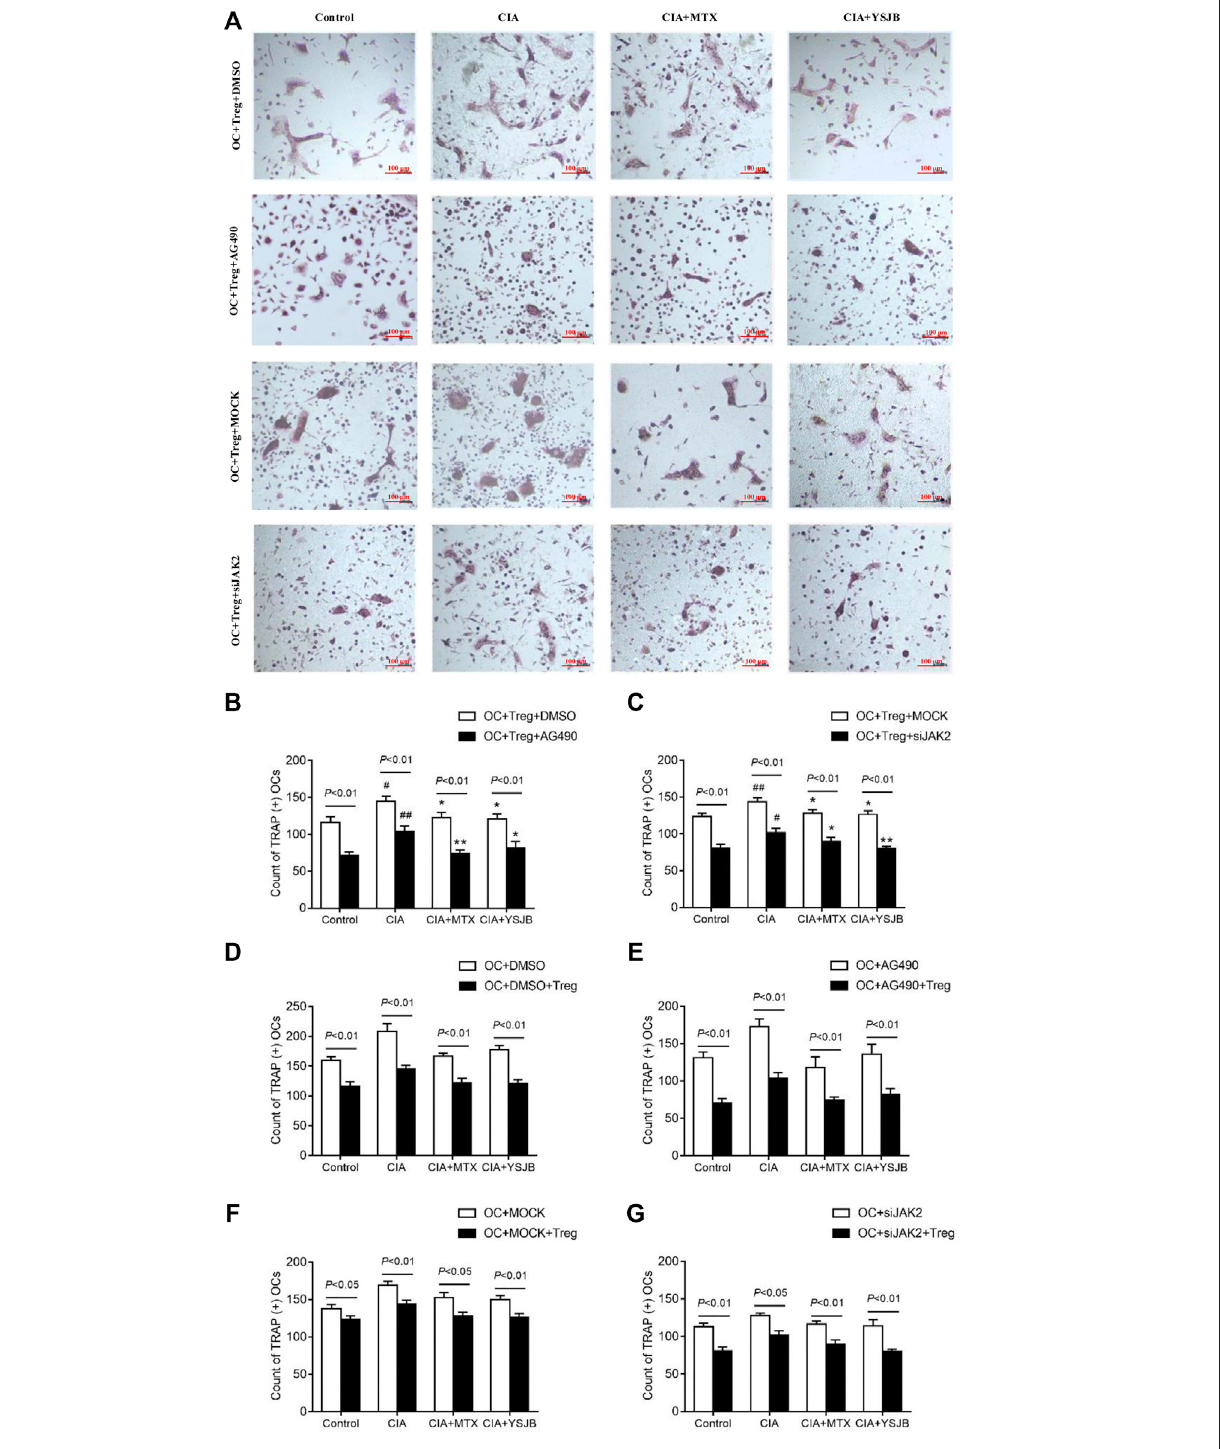
FIGURE 4 | Effect of YSJB, AG490 and JAK2 siRNA on osteoclastogenesis in the OC-Treg coculture system (25:1). (A) Images of TRAP staining in the coculture system after treatment with drug-containing serum (Control, CIA, CIA + MTX, CIA + YSJB), AG490 and JAK2 siRNA. Scale bar (cid:2) 100 μ m. (B,C) The number of TRAP + cellsinthecoculturesystemtreatedasdescribedin (A) . (D – G) ThenumberofTRAP + OCsaftertheadditionofTregs.Thedataareshownasthemean ± SEM(n ≥ 2). # p < 0.05, ## p < 0.01 compared with the control group; * p < 0.05, ** p < 0.01 compared with the CIA group.